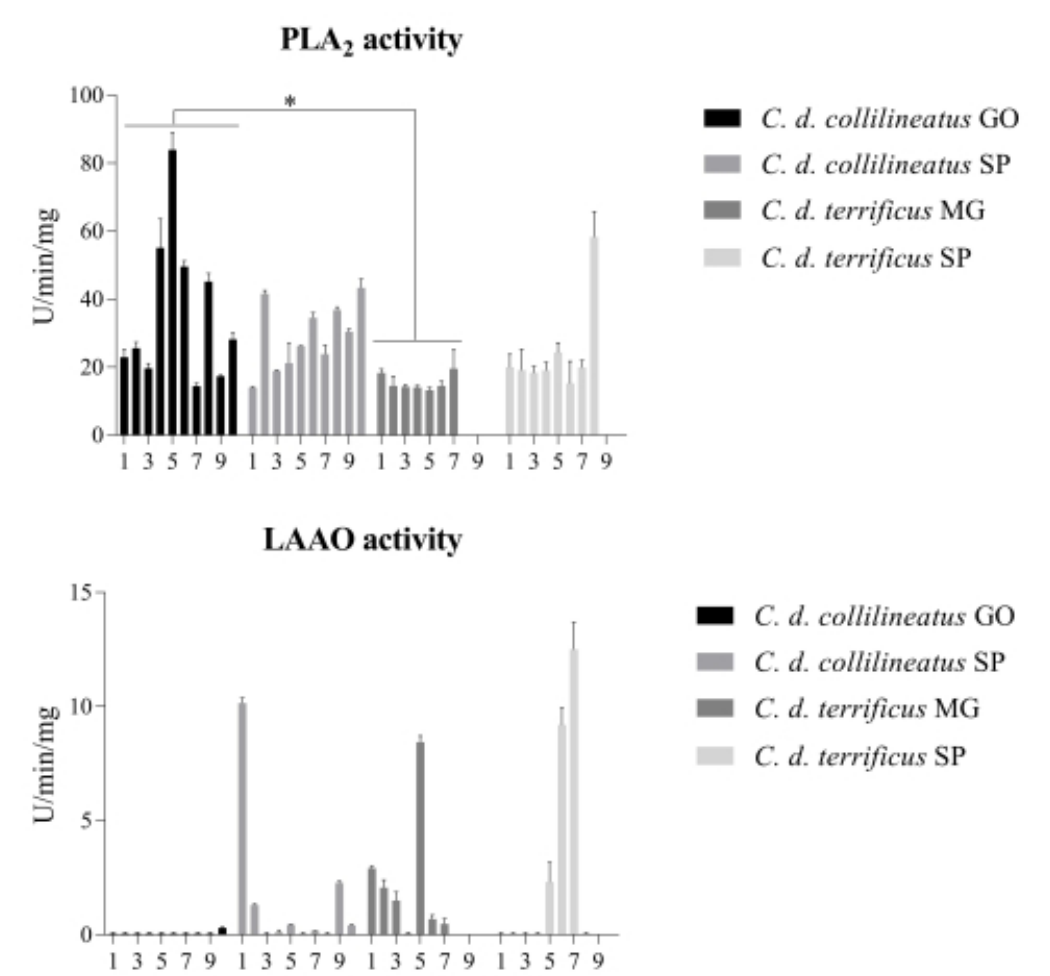
activity and ( B ) L-amino acid oxidase activity. Results 2